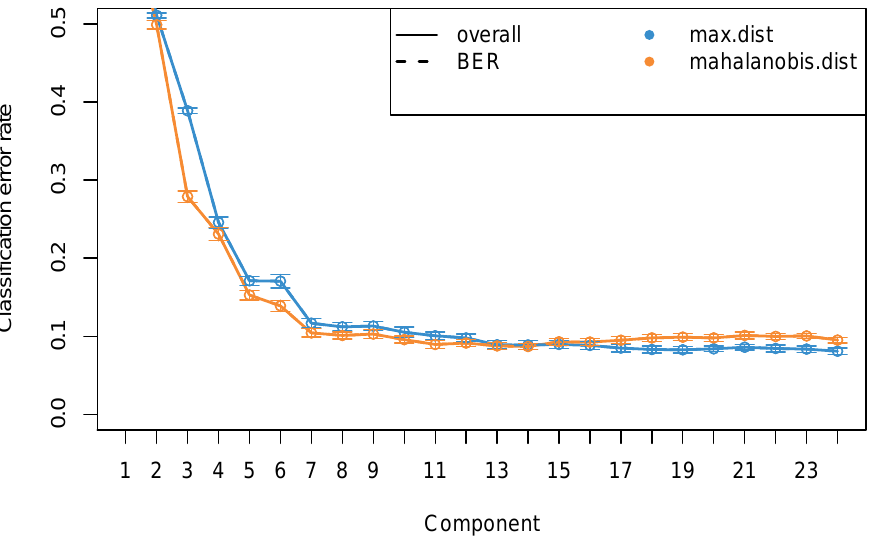
Figure 17. PLSDA classification errors for biofuel materials, overall —overall error rate, BER — balanced error